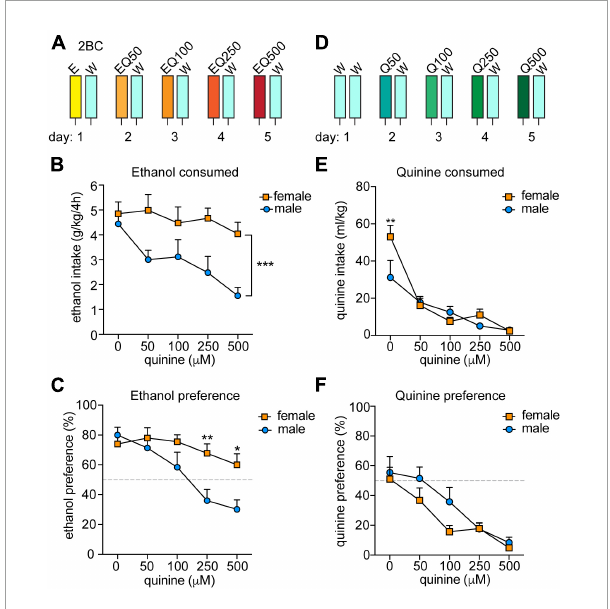
FIGURE1 Sex differences in aversion-resistant ethanol consumption. (A) Experimental design for measuring aversion-resistant ethanol consumption. Mice ( n = 11 males and 12 females) were given a two-bottle choice (2BC) ethanol drinking in the dark test with 15% ethanol (E) and water (W) on the first day. Each day, the quinine (Q) concentration was increased in the ethanol from 50 to 500 µ M (EQ50, EQ100, EQ250, and EQ500). (B) Daily ethanol consumed in g per kg body weight over 4 h. *** P < 0.001, effect of sex by two-way RM ANOVA. (C) Daily ethanol preference, expressed as ethanol consumed divided by total fluid consumed × 100. ** P < 0.01 and * P < 0.05 when comparing females to males at EQ250 and EQ500, respectively, by Bonferroni’s post-hoc multiple comparisons testing. (D) Experimental setup for measuring quinine consumption. Mice ( n = 8 males and 8 females) underwent 2BC in the dark on the first day with water only and then with quinine doses increasing daily from 50 to 500 µ M (Q50, Q100, Q250, and Q500). (E) Daily quinine consumed in ml quinine per kg body weight over 4 h. ** P < 0.01 when comparing females to males in water consumption by Bonferroni’s post-hoc multiple comparisons testing. (F) Daily quinine preference, expressed as quinine consumed divided by total fluid consumed ×